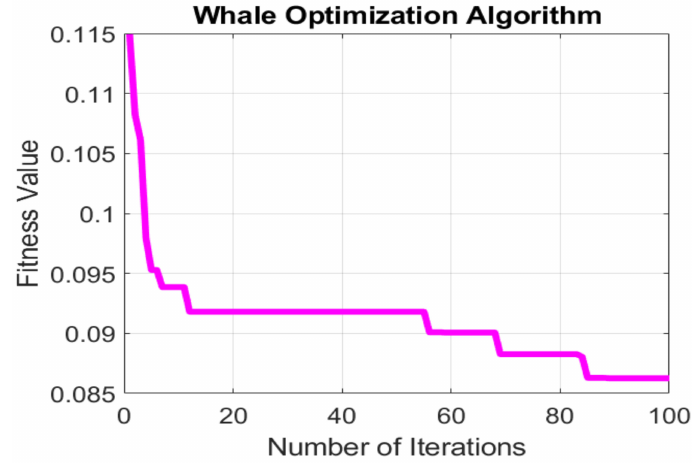
Figure 3. Graphical representation of WOA.